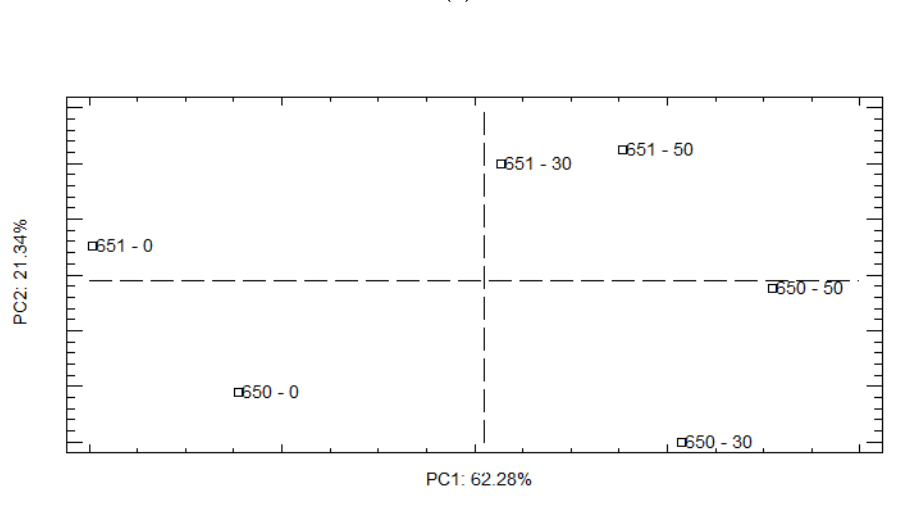
Figure 4. Analysis of principal components ( a ) loading and ( b ) score plots. WBC: water binding capac- ity, WHC: water holding capacity, WAI: water absorption index, WSI: water solubility index, OAC: oil absorption capacity. To: onset temperature, Tp: peak temperature, Tc: conclusion